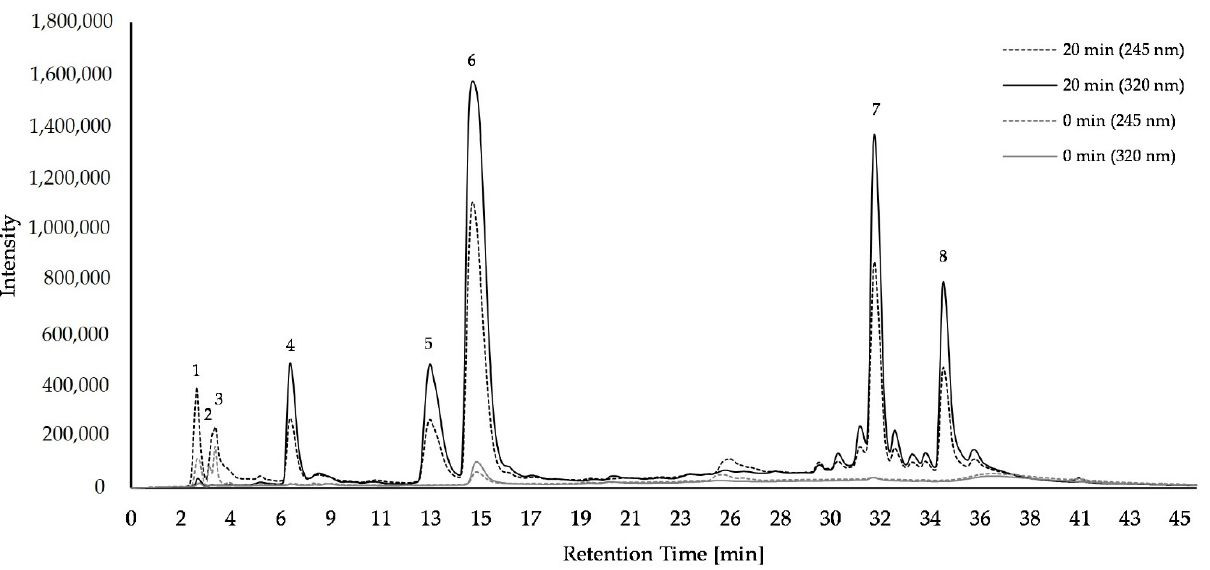
Figure 2. Chromatogram of ascorbic acid and phenolic compounds in Aegopodium podagraria L. samples detected by HPLC-DAD after freeze-drying without storage at wavelengths of 245 nm (dotted line) and 320 nm (solid line). Cooking time of 0 min (gray) and 20 min (black); 1–3: ascorbic acid and it derivates; 4: 3-caffeoylquinic acid; 5: caffeoylquinic acid dimer; 6: 5-caffeoylquinic acid; 7: di-caffeoylquinic acid; 8: kaempferol-3-glucosid.